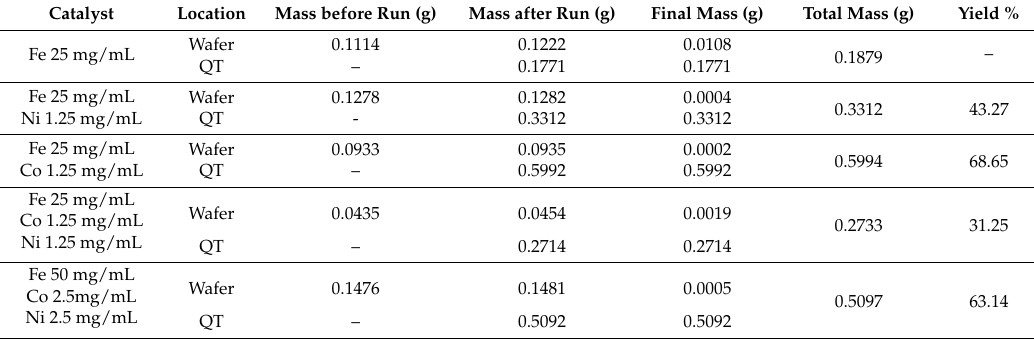
Table 1. MWNT production using a combination of various